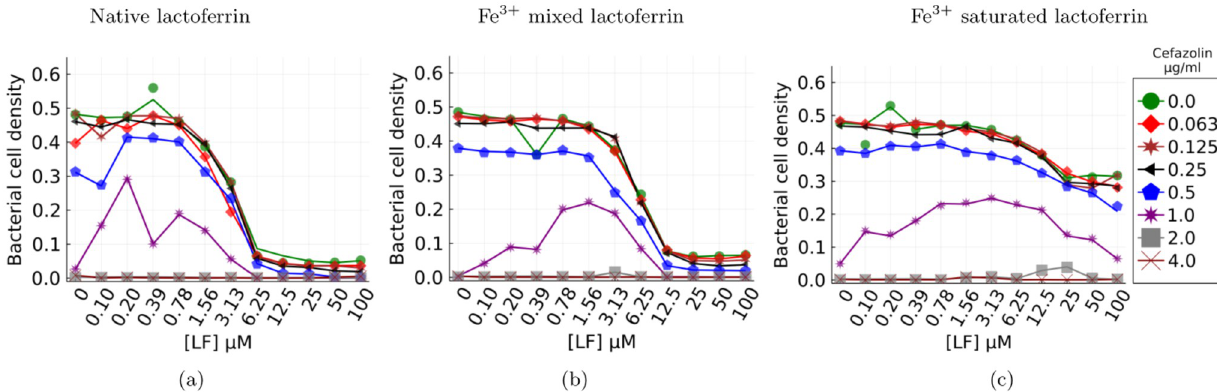
Fig 2. Kinetic model prediction vs experimental data. The kinetic ode model was parameterised to fit the experimental data, the model results (solid lines) are plotted against the experimental data (points). One model ([ Fe 3+ ]) parameter was a function of the lactoferrin Fe 3+ saturation level, all others remained the